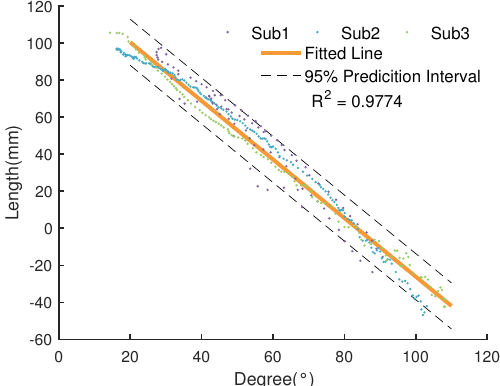
Figure 3. Relationship between the angle of hip joint and the length of Bowden cable. Where the angle of 0 represents the thigh is perpendicular to upper body, the position of 0 represent the position of Bowden Cable when the lower limb remains upright, the R 2 is the coefficient of